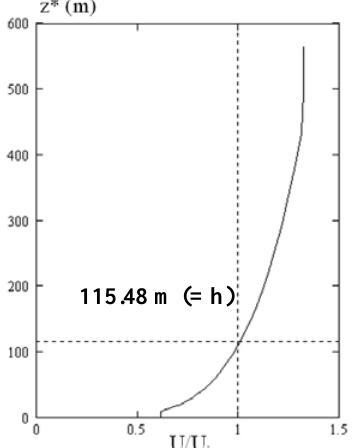
Figure 6. Non-dimensional inflow profile.